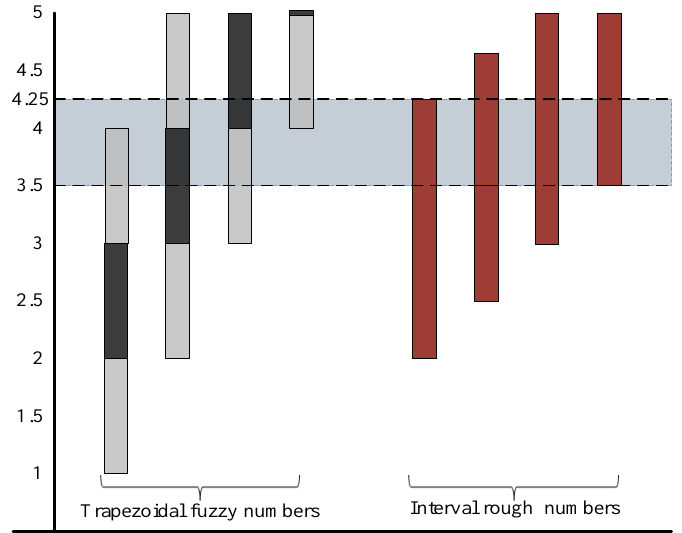
Figure 3. Criterion evaluation — interval rough and fuzzy evaluation.